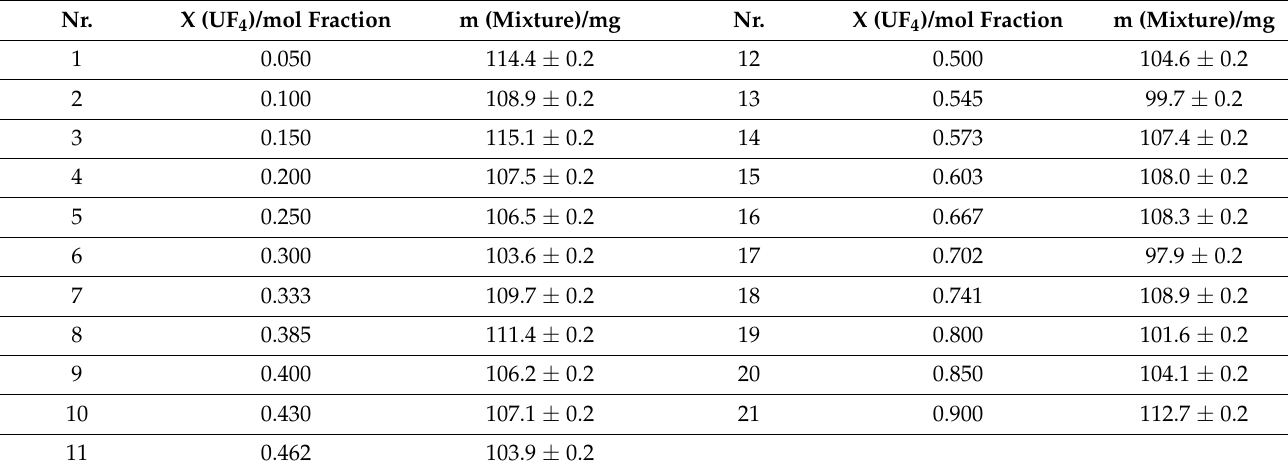
Table 2. Intermediate KF-UF 4 compositions subjected to DSC measurements within in this study.